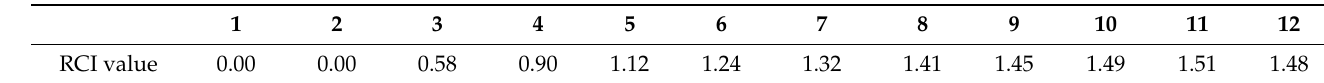
Table 2. Saaty’s ratio index.